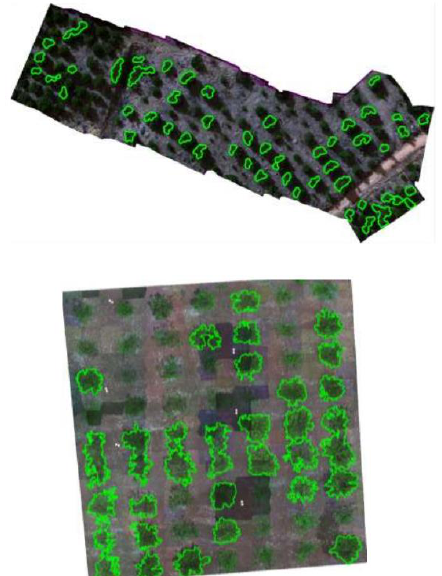
Figure 8. Valley following